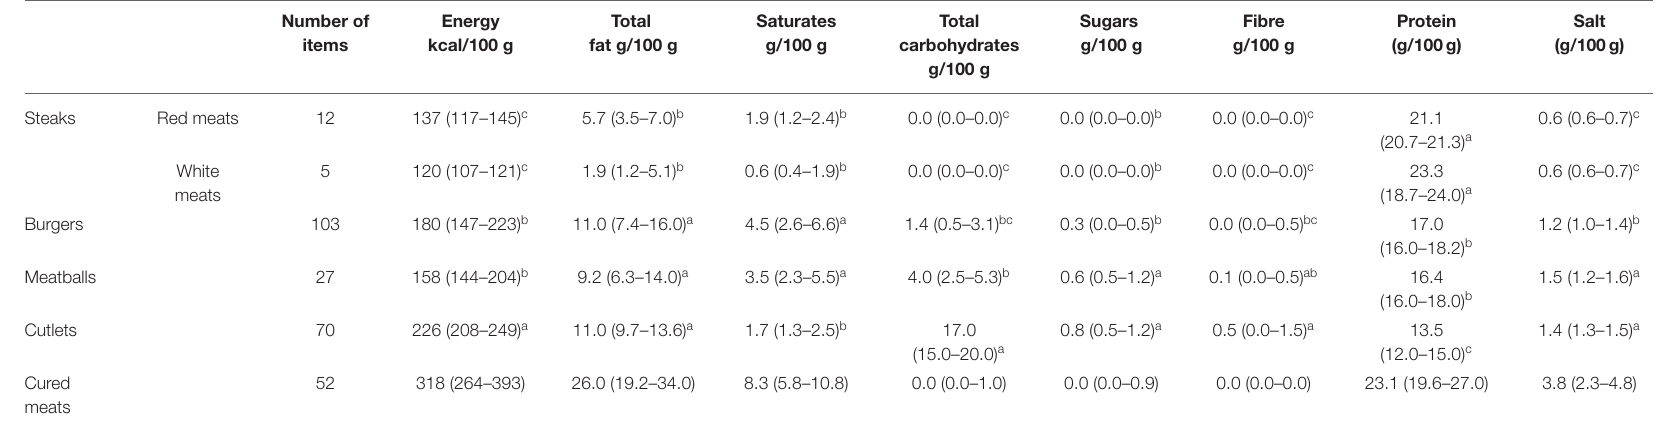
TABLE 3 | The number of items and nutrition declaration of meat